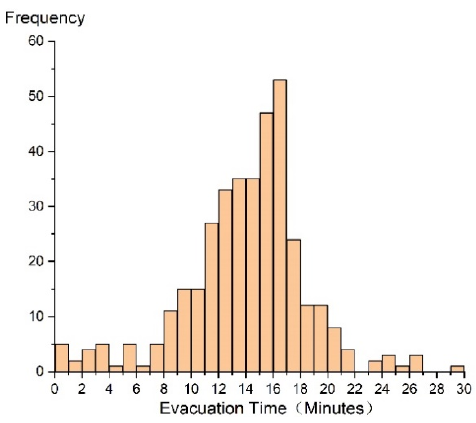
Figure 11. The optimal shelter location scheme.